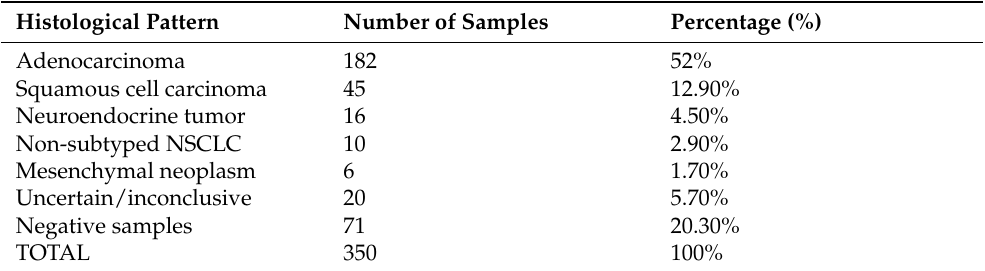
Table 3. Microhistological evidence from transthoracic biopsy